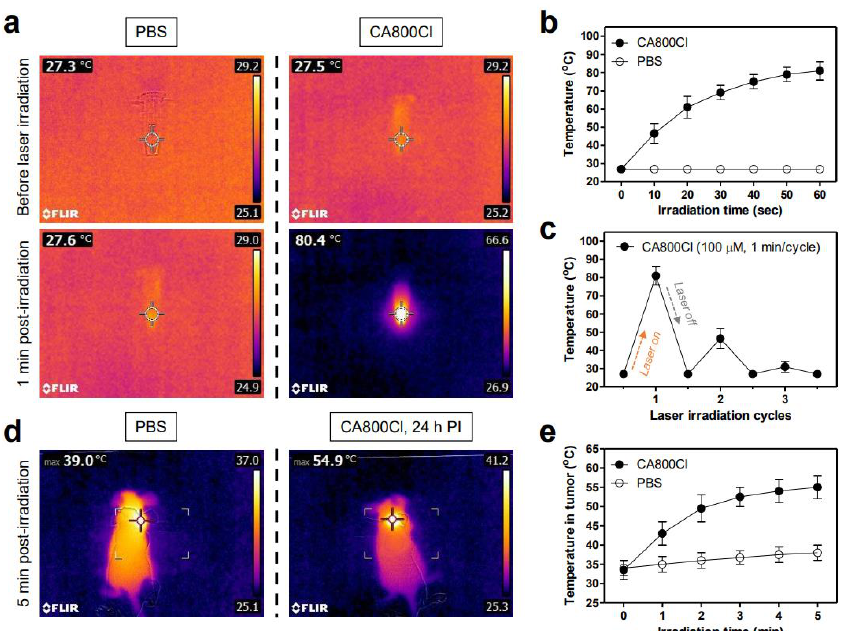
Figure 5. ( a ) In vitro photothermal images of CA800Cl solution (100 μM in PBS) and PBS alone (100 μL) exposed to an 808 nm laser (1.1 W/cm 2 ) for 1 min. The maximum temperature was automatically recorded using an infrared thermal camera as a function of irradiation time. ( b ) Temperature changes in the solutions in each sample were monitored during the 1 min of laser irradiation. ( c ) Photothermal stability curve of 100 μM CA800Cl solu tions after repeated laser irradiation (1 cycle = 1 min of laser irradiation). ( d ) Whole-body photothermal images of tumor-bearing mice 24 h post- injection of PBS or CA800Cl upon exposure to 808 nm laser irradiation (1.1 W/cm 2 ) for 5 min. ( e ) Temperature changes at the tumor sites in each treatment group were monitored during the 5 min of 808 nm laser irradiation. Data are expressed as mean ± S.D. (n = 3).